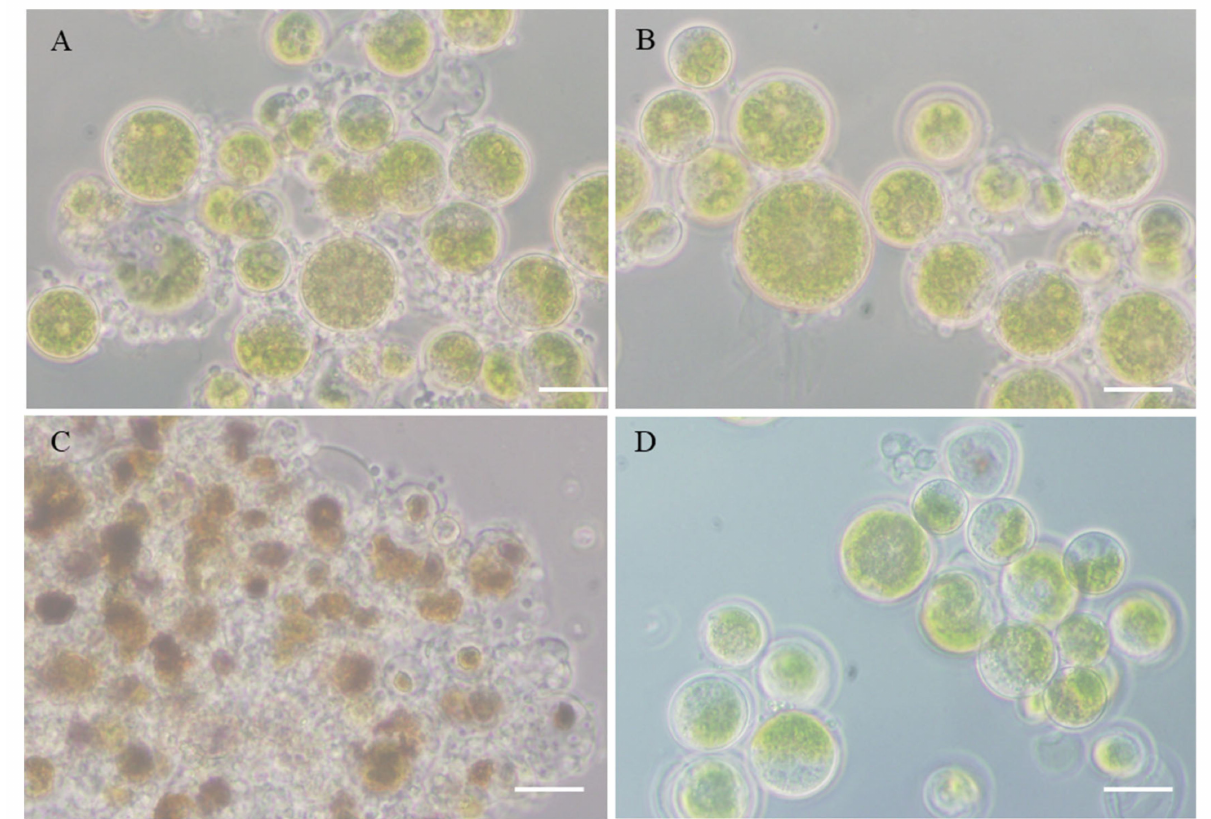
Figure 2. Microscopic images of P. sedebokerense infection development in H. lacustris cultures, in the absence ( A , C ) or presence ( B , D ) of 2.5 mM glufosinate. ( A , B ), and ( C , D ) The upper images were taken 3 h after inoculation, whereas the bottom images were taken 9 days after inoculation of the infecting the co-cultures. Glufosinate did not prevent the encystment of the propagules 3 h after inoculation ( B ) but prevented the development of the infection and the collapse of the algal culture up until 9 days ( D ). Scale bar 20 µ